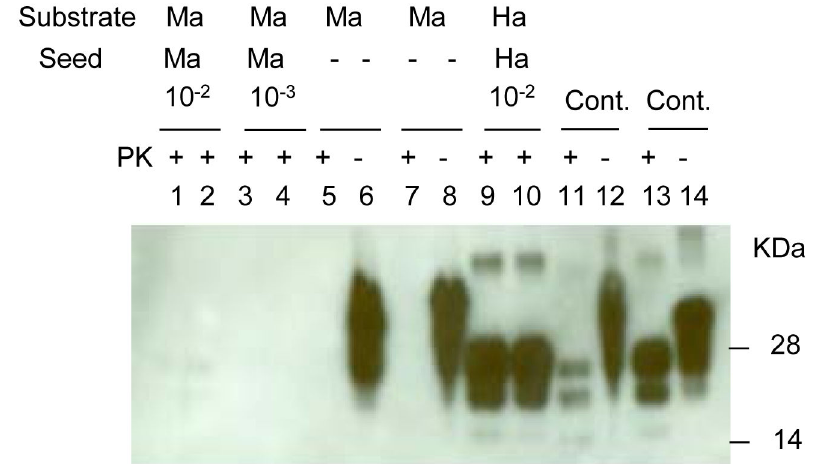
Figure 1. Intraspecies PMCA with vCJD macaque brain homogenate. A 10% suspension of brain tissue from macaque with terminal vCJD was diluted 10 -2 or 10 -3 into 10% normal macaque brain homogenate and subjected to 1 round of PMCA (lanes 1-4). Lanes 5-8 indicate 10% macaque NBH without seed subjected to 1 round of PMCA. A 10% brain homogenate from hamsters infected with scrapie (263K) was diluted 10 -2 fold into 10% hamster NBH and subjected to 1 round of PMCA (lanes 9-10). Macaque vCJD brain homogenate (1%) was loaded in lanes 11-12 and 1% 263K scrapie hamster brain homogenate was loaded in lanes 13-14 as positive controls (Cont.). Prior to electrophoresis, samples were digested with proteinase K (PK) as indicated. The blot was stained with 3F4 antibody. Ma = macaque; Ha = hamster; PK = proteinase